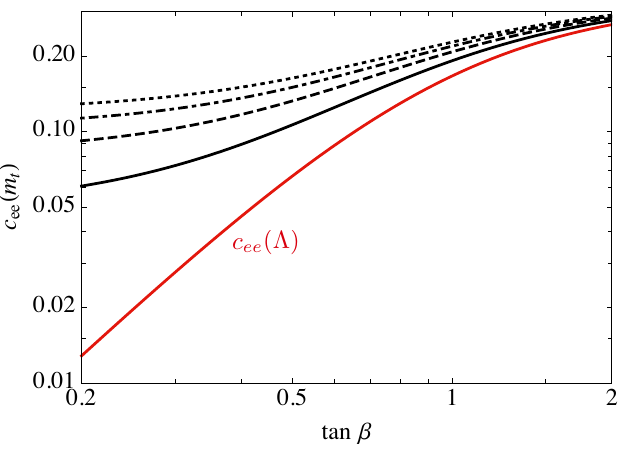
Figure 6 . Axion-electron coupling c ee ( m t ) in the DFSZ model for different values of tan β = v u /v d and axion masses: m a = 1 keV (solid), 1 eV (dashed), 1 meV (dashed-dotted) and 1 µ eV (dotted). The red curve depicts the coupling c ee (Λ) at the high scale Λ = 4 πf